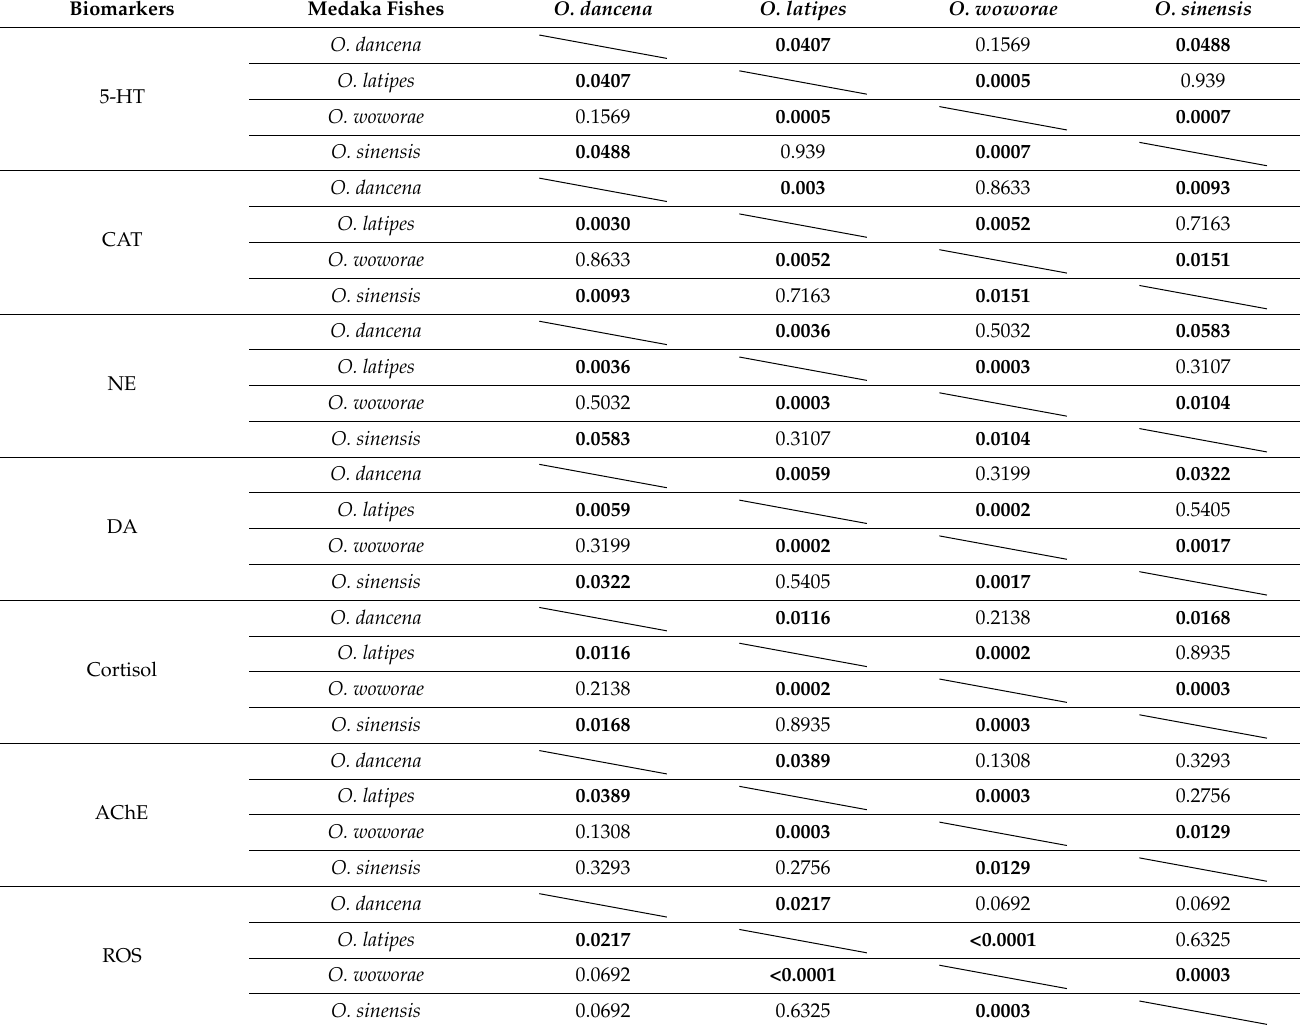
Table A3. The individual P-value of each medaka fish’s neurotransmitters, antioxidant activity, and oxidative stress content comparisons in the biochemical tests. The p -values were obtained from a Kruskal–Wallis test continued with uncorrected Dunn’s test. p -values less than 0.05 are written in